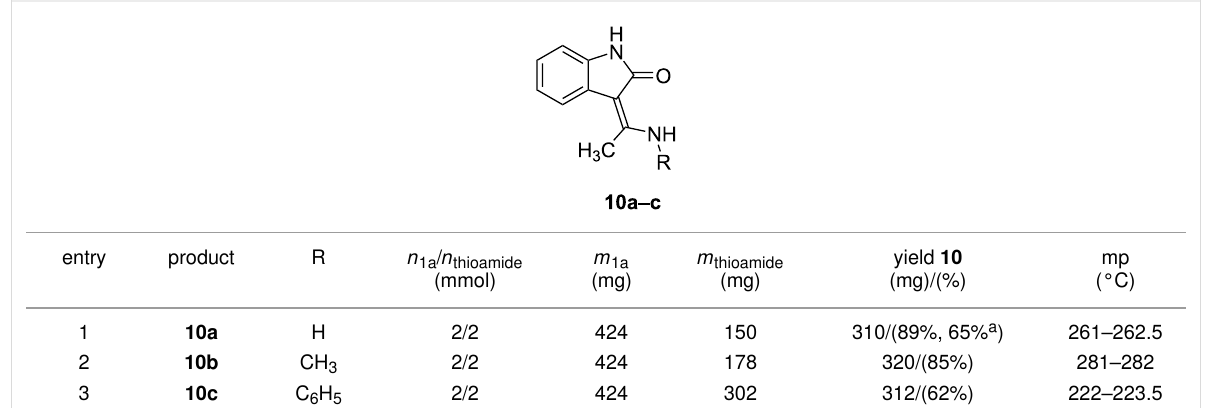
Table 5: The prepared ( Z )-3-[1-aminoethylidene]-1,3-dihydro-2 H -indol-2-ones 10a–c